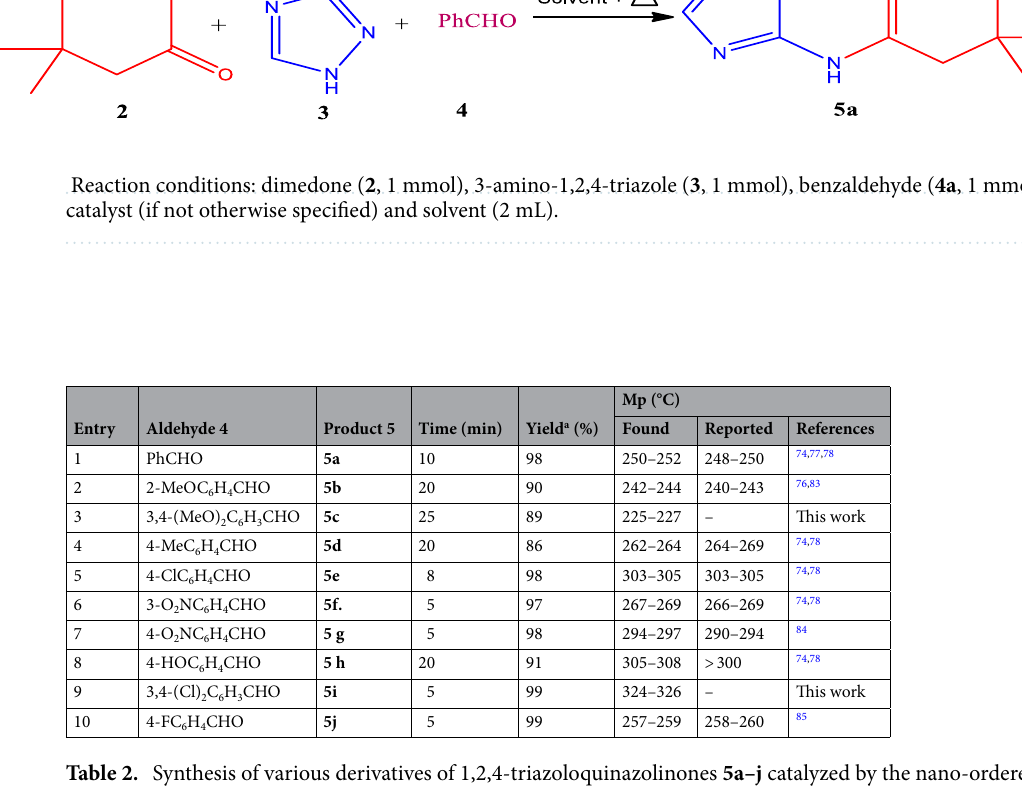
Table 2. Synthesis of various derivatives of 1,2,4-triazoloquinazolinones 5a–j catalyzed by the nano-ordered Melamine@TMG organocatalyst ( 1